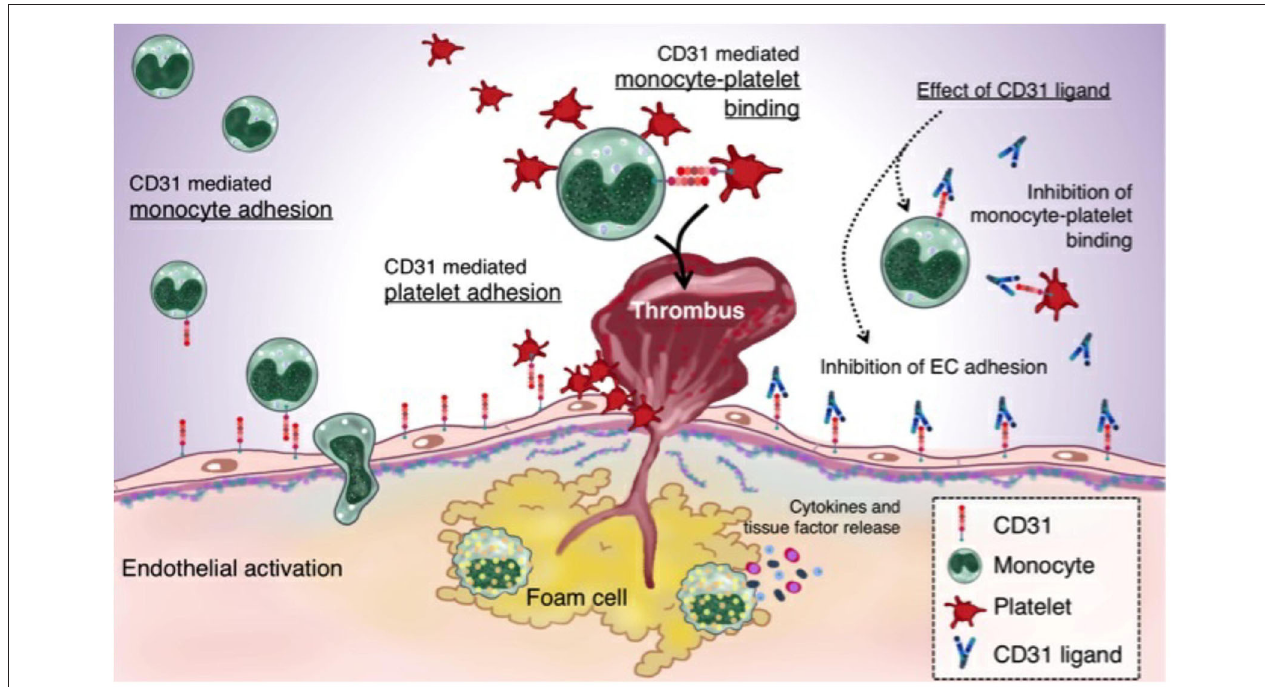
FIGURE 8 | CD31 and the thromboinflammatory response of the unstable plaque: A plaque rupture paradigm. The figure summarizes the driving hypothesis that derives from both the existing evidence on plaque rupture and the data that emerged from the present study. In ACS, CD31 is involved in leukocytes and platelets adhesion on ECs. The increased monocyte-platelet (Mo-Plt) binding in the RFC milieu might account for an increased athero-thrombotic burden driven by the inflammation and involving, at least in part, CD31 molecule, as demonstrated by the significant reduction of Mo-Plt aggregate formation following the CD31 ligation (ACS, acute coronary syndromes; and endothelial cells,